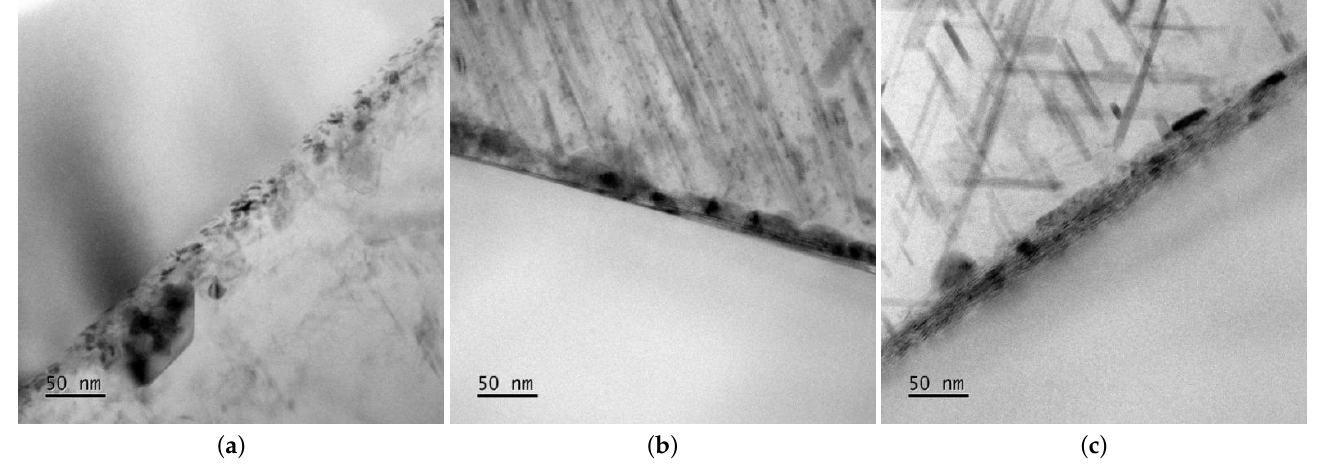
Figure 9. TEM images of Precipitates near grain boundaries in SiCp–AA2009 composites under ( a ) CHT-UA (CHT with 4 h ageing); ( b ) CHT-PA (CHT with 20 h ageing) and ( c ) DCT-PA (DCT with 20 h